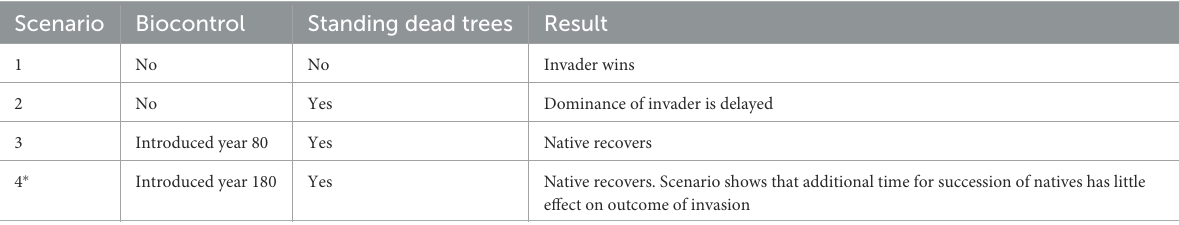
TABLE 1 Summary of four scenarios involving taking standing dead into account. Scenario Biocontrol Standing dead trees